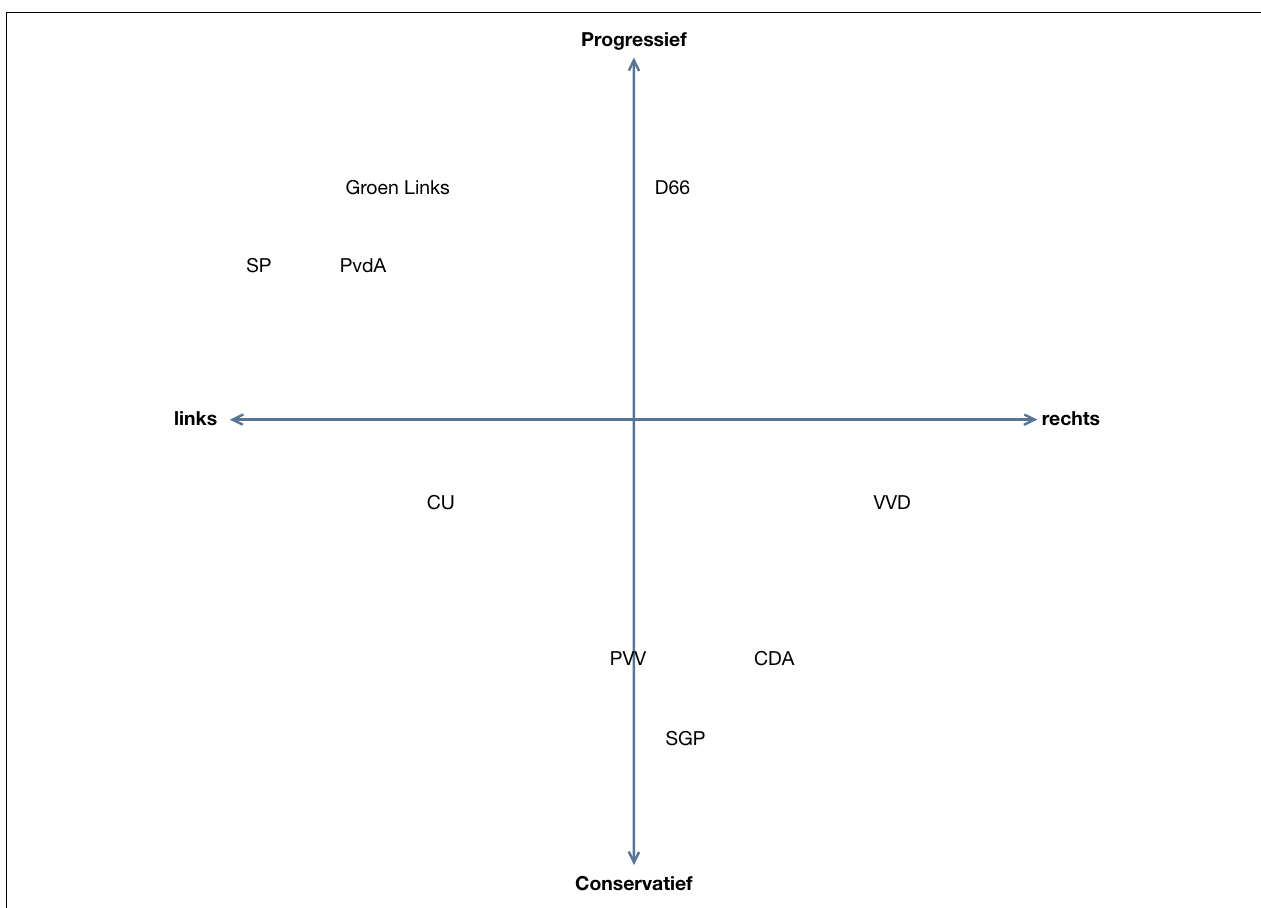
FIGURE 2 | Overview of political parties on the grid for the general elections 2010 in the Netherlands.